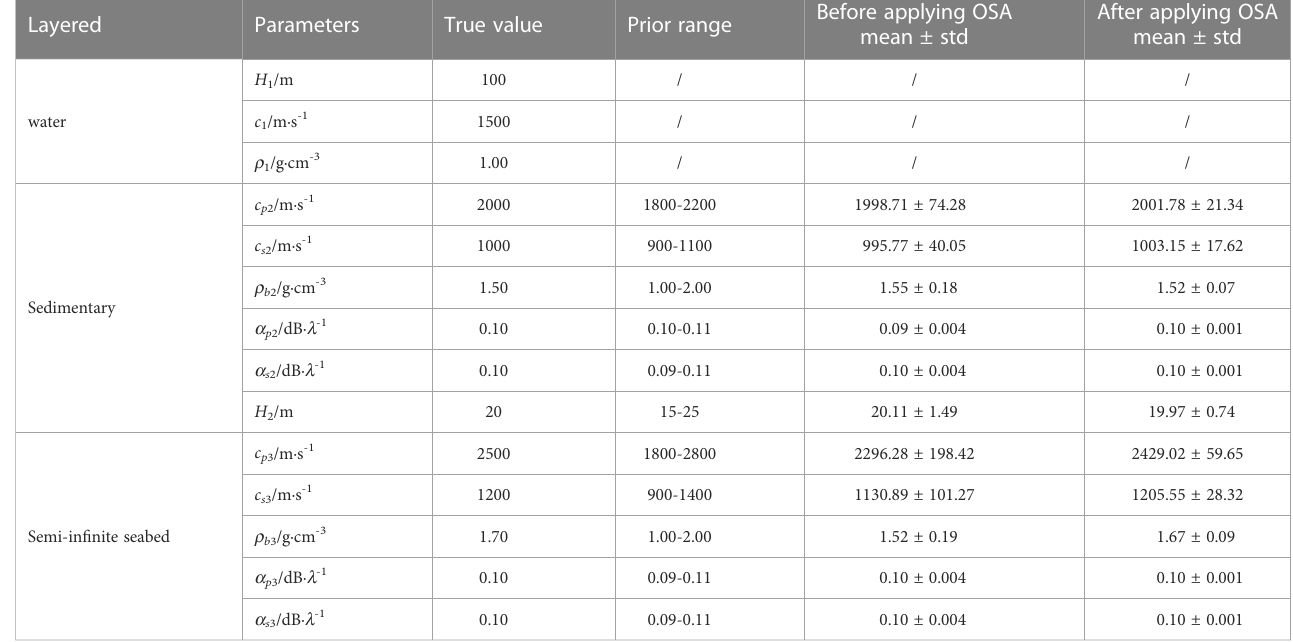
Before applying OSA mean ± std